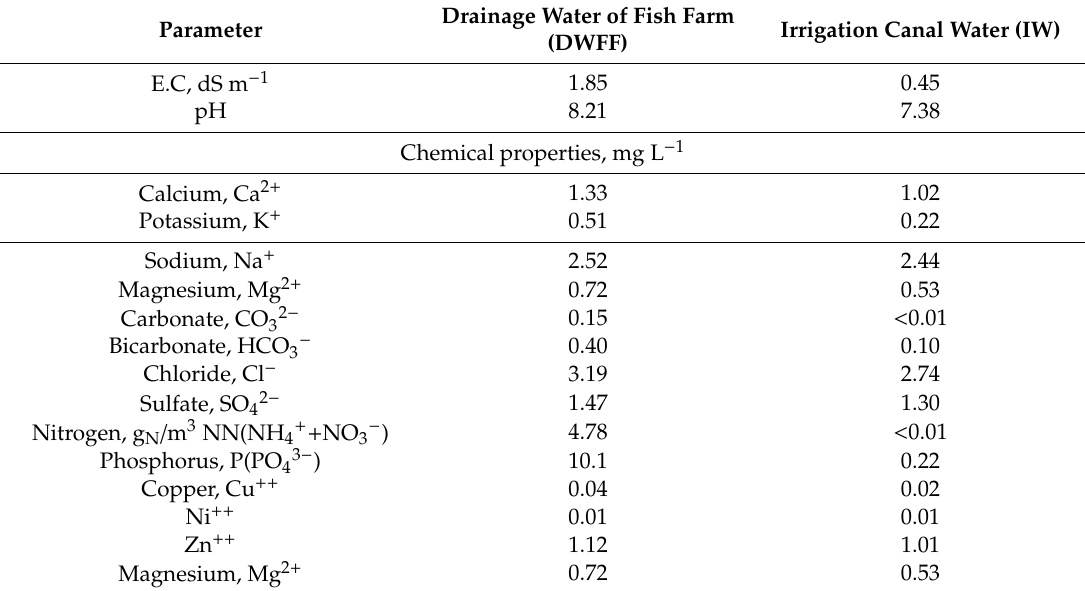
Table 3. Some properties of drainage water from fish farms and fresh irrigation